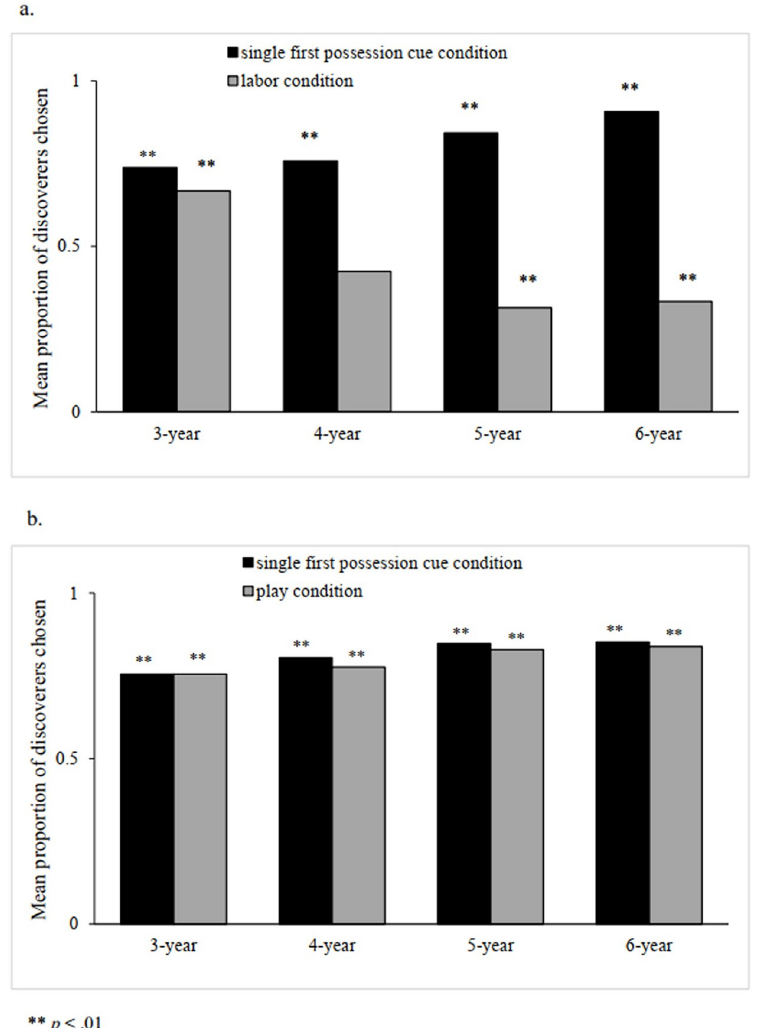
Fig 4. Choices of discoverers over modifiers in Study 2. a. First possession versus labor group, b. First possession versus play